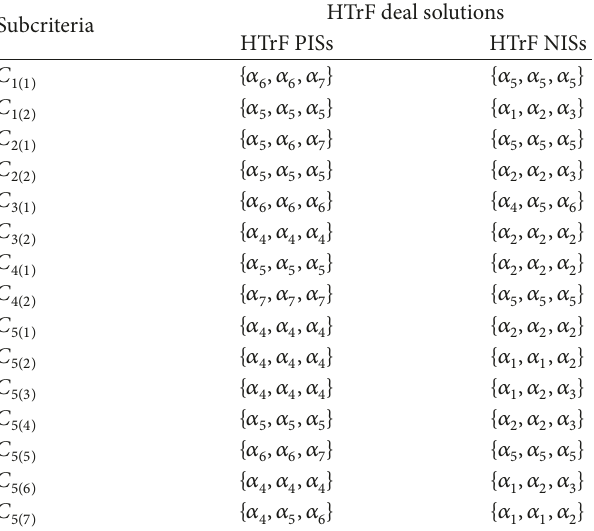
Table 4: HTrF PISs and HTrF